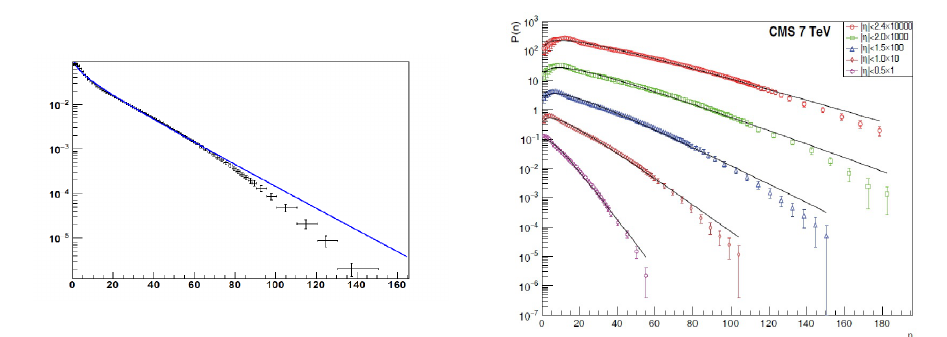
Figure 1: Plots of charged particle multiplicity distribution obtained at 13TeV by the ATLAS collaboration (left) and at 7TeV by the CMS collaboration (right) [4]. The data from ATLAS is obtained with η < 2 . 5 while that from CMS covers the di ff erent η values up to η < 2 . 4. Both plots were described using the SIMD with the parameters given in Table